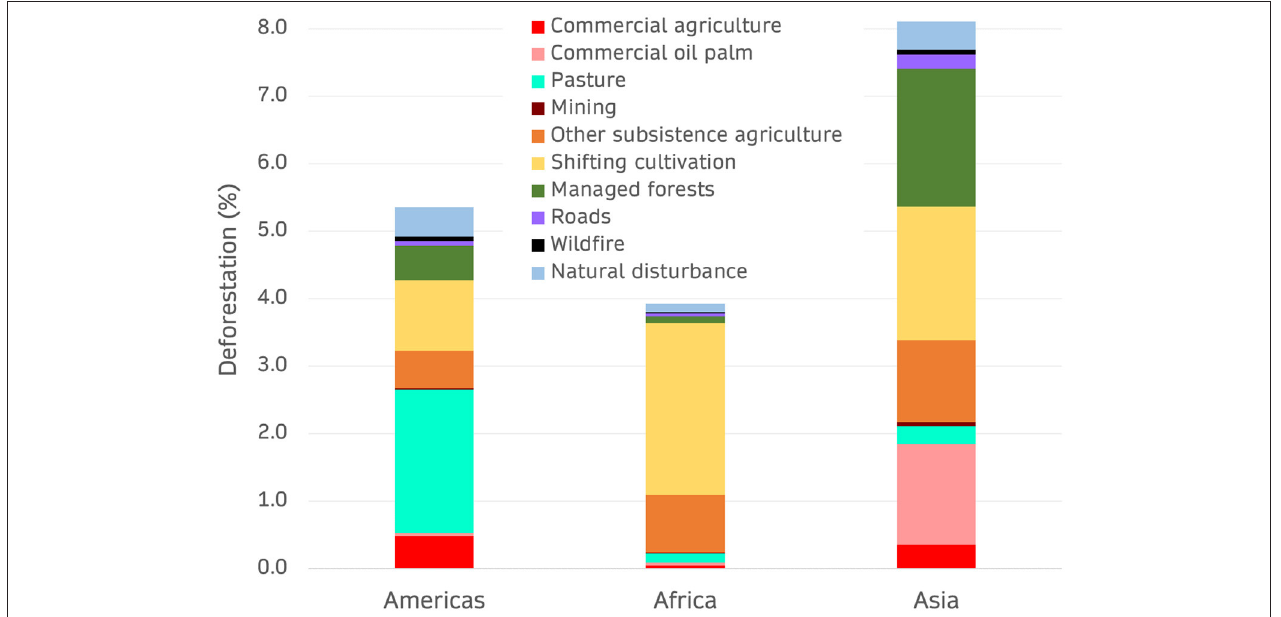
FIGURE 4 | Percentage deforestation by driver for the Americas, Africa, and Asia in the area 30 ◦ latitude north and south of the equator.